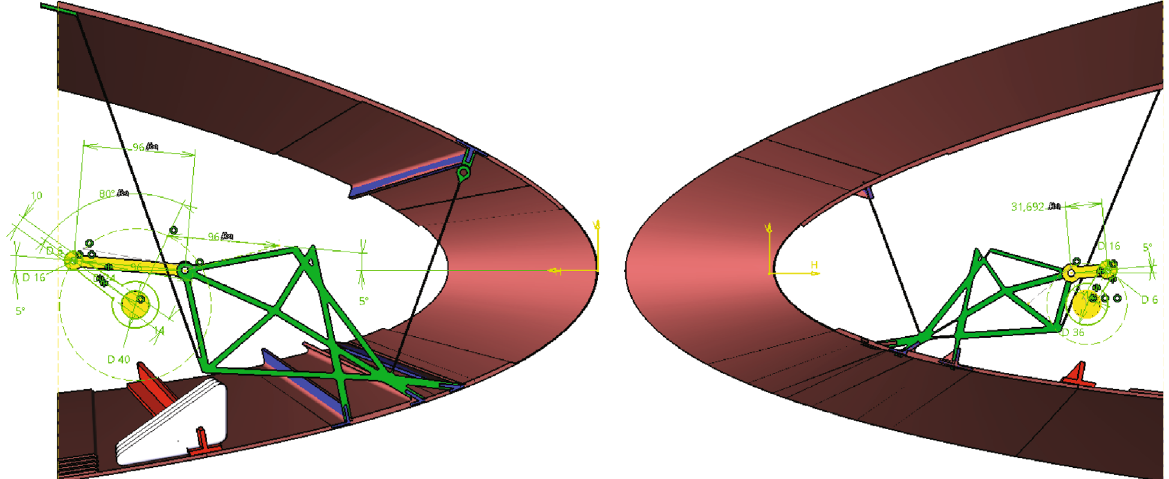
Figure 18: Parametric CAD model of the kinematic chain for the actuation system. Root section (left) and tip section (right).